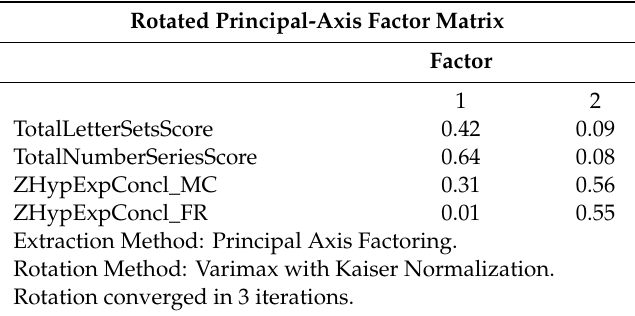
Table 12. Study 2 Rotated Principal-Axis Factor